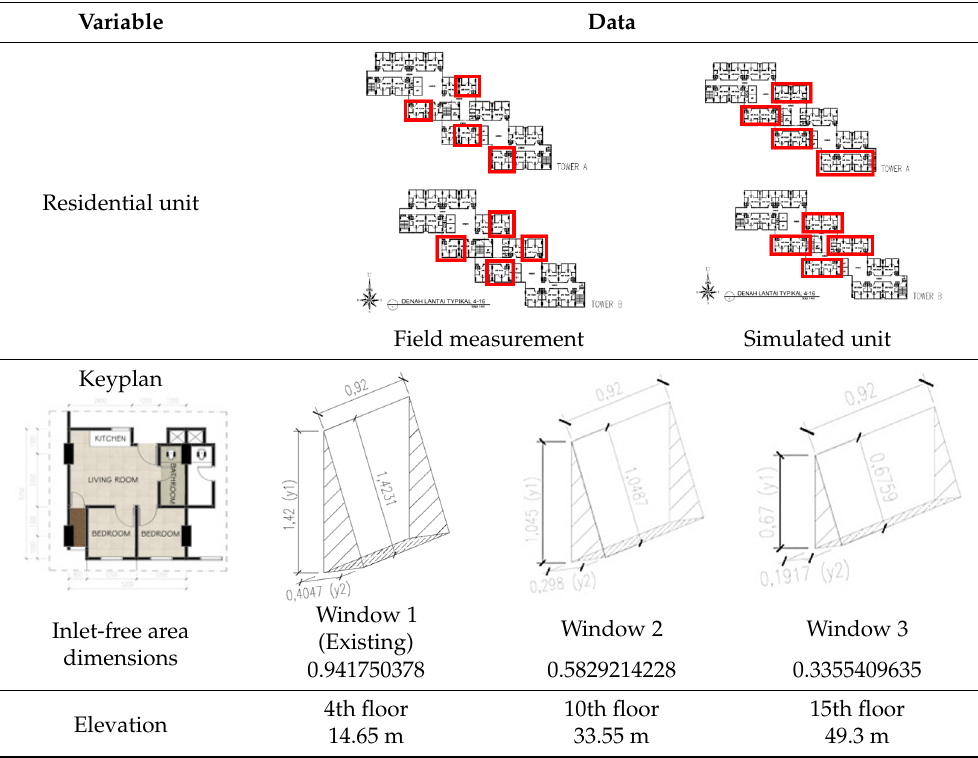
Table 3. Simulation data.